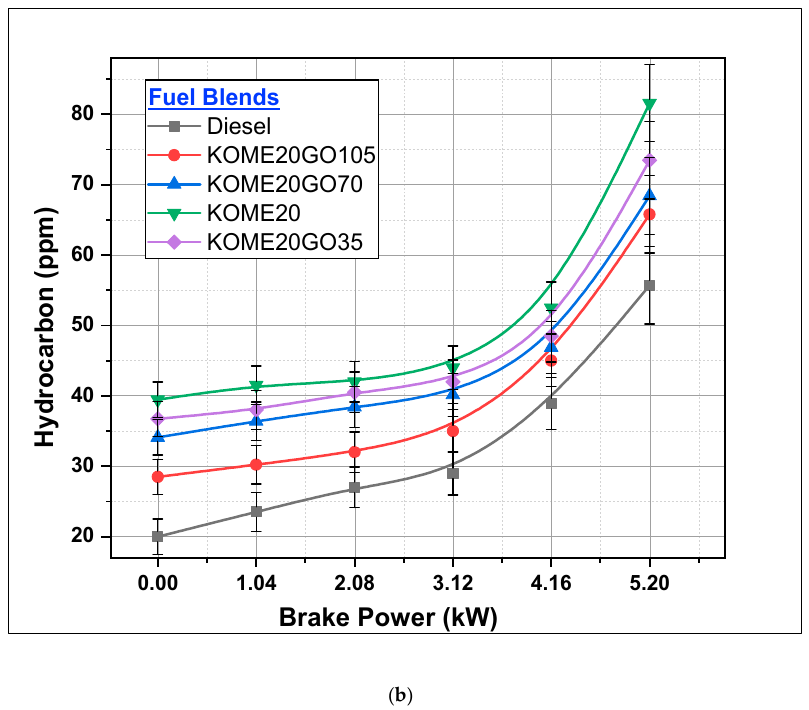
Figure 12. Variations in hydrocarbon formation with Biodiesel-Diesel-Nano blends ( a ) NOME20 ( b ) KOME20.